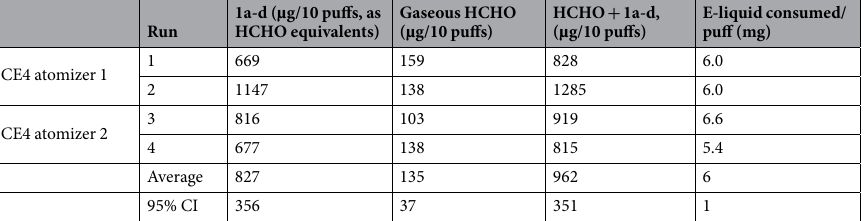
Table 1. Levels of 1a-d , HCHO and e-liquid consumed (commercial Café Mocha brand, the same used in our 2015 study, ref. 6 ) from four vaping sessions with two CE4 atomizers at a power level of 4.0 V. Several-fold more 1a-d is produced compared to HCHO. The p -value is 0.00049. The result is significant at p < 0.05. The levels of 1a-d are reported for 10 puffs (for comparison to literature values), but were obtained from 50 puff vaping sessions.